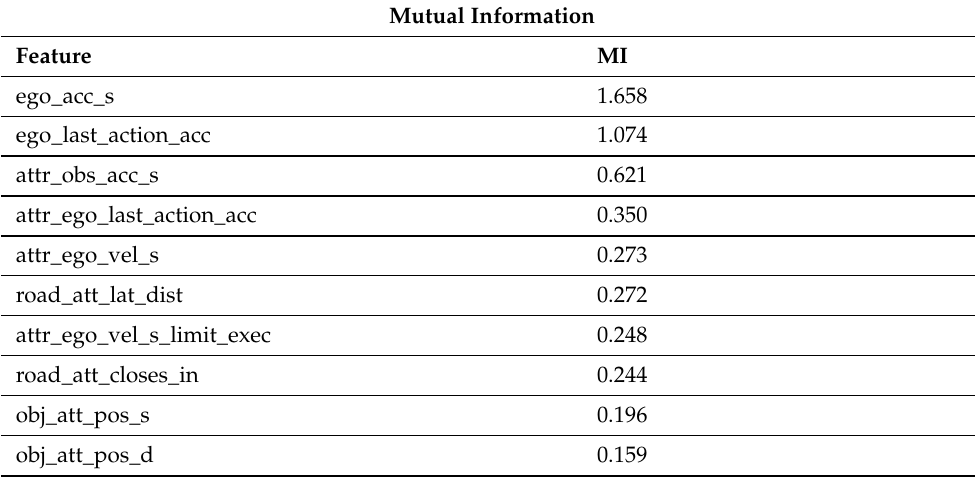
Table 3. Table with values of highest mutual information for action of ACC agent with respect to values of ego’s features and